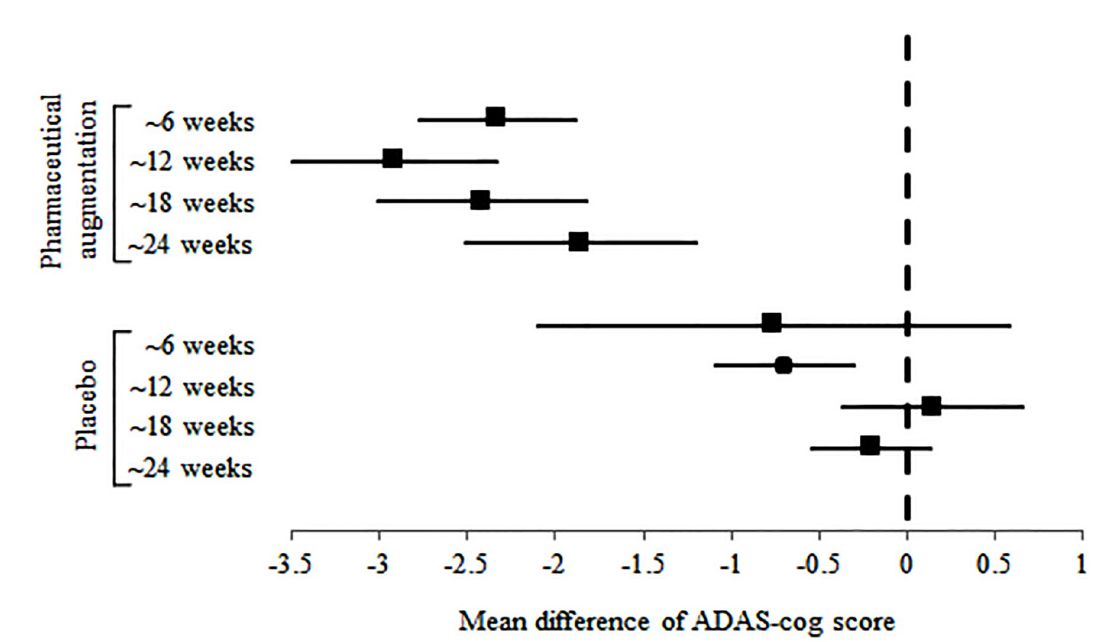
Fig 3. The mean difference of ADAS-cog score according to the pharmaceutical